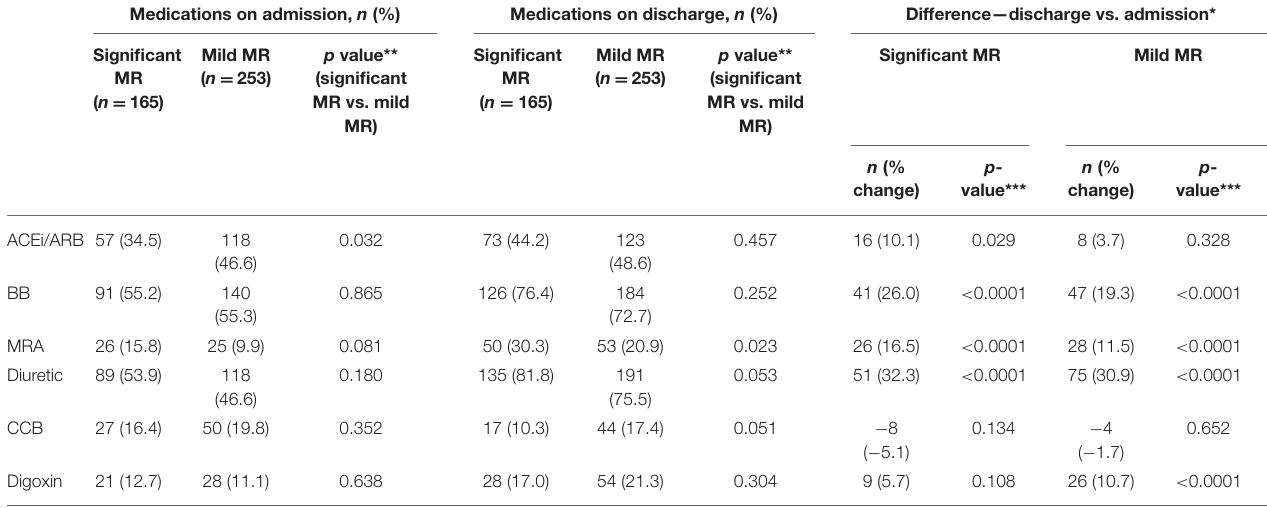
TABLE 2 | Medical therapy on admission and discharge. Medications on admission, n (%)